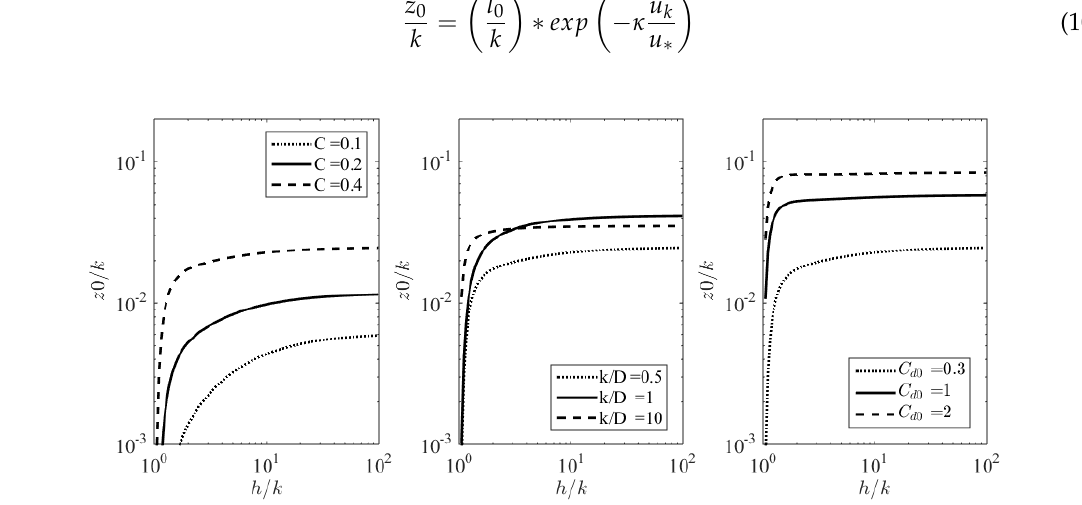
Figure 14. Hydraulic roughness as a function of the confinement around a rough bed case C = 0.4, k / d = 1, C d 0 =